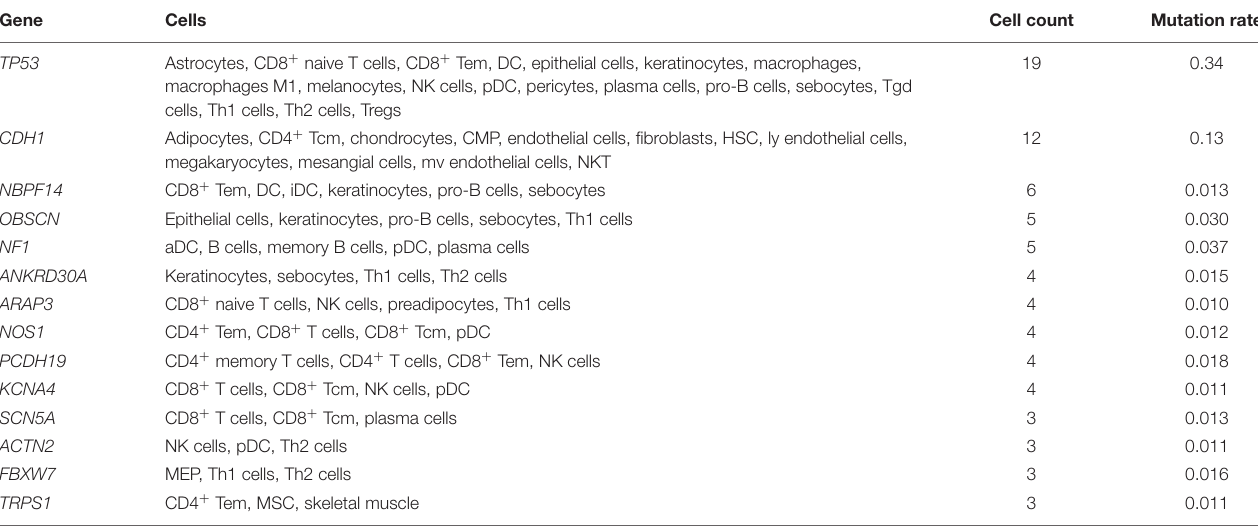
TABLE 1 | The summary results of immune cells driven by somatic mutation genes. Gene Cell count Mutation rate